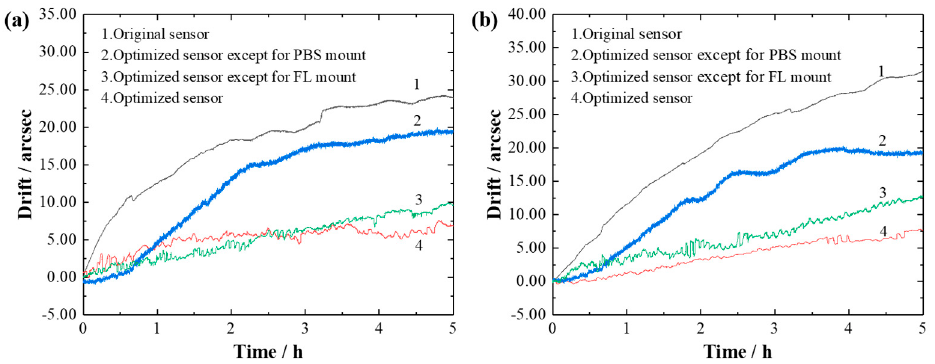
Figure 10. The drift of the sensors for ( a ) yaw and ( b ) pitch.